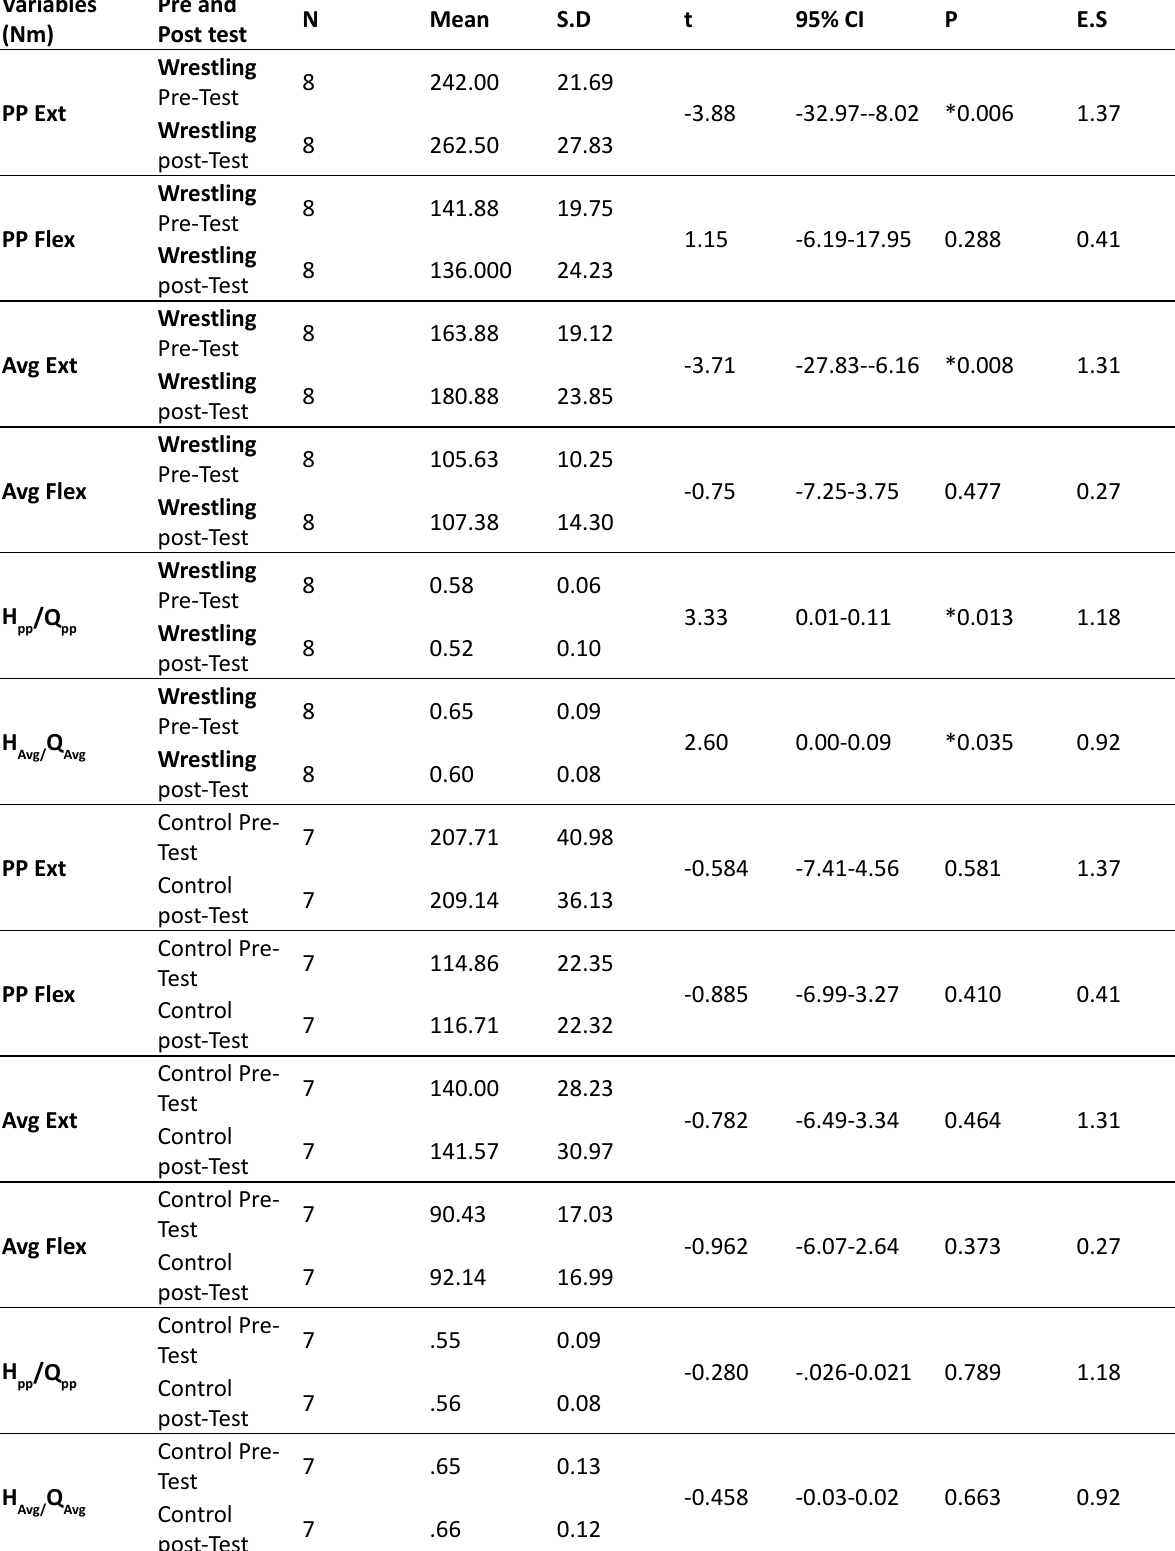
Table 1. Right leg pre and post-test isokinetic torque outputs of wrestling and control groups